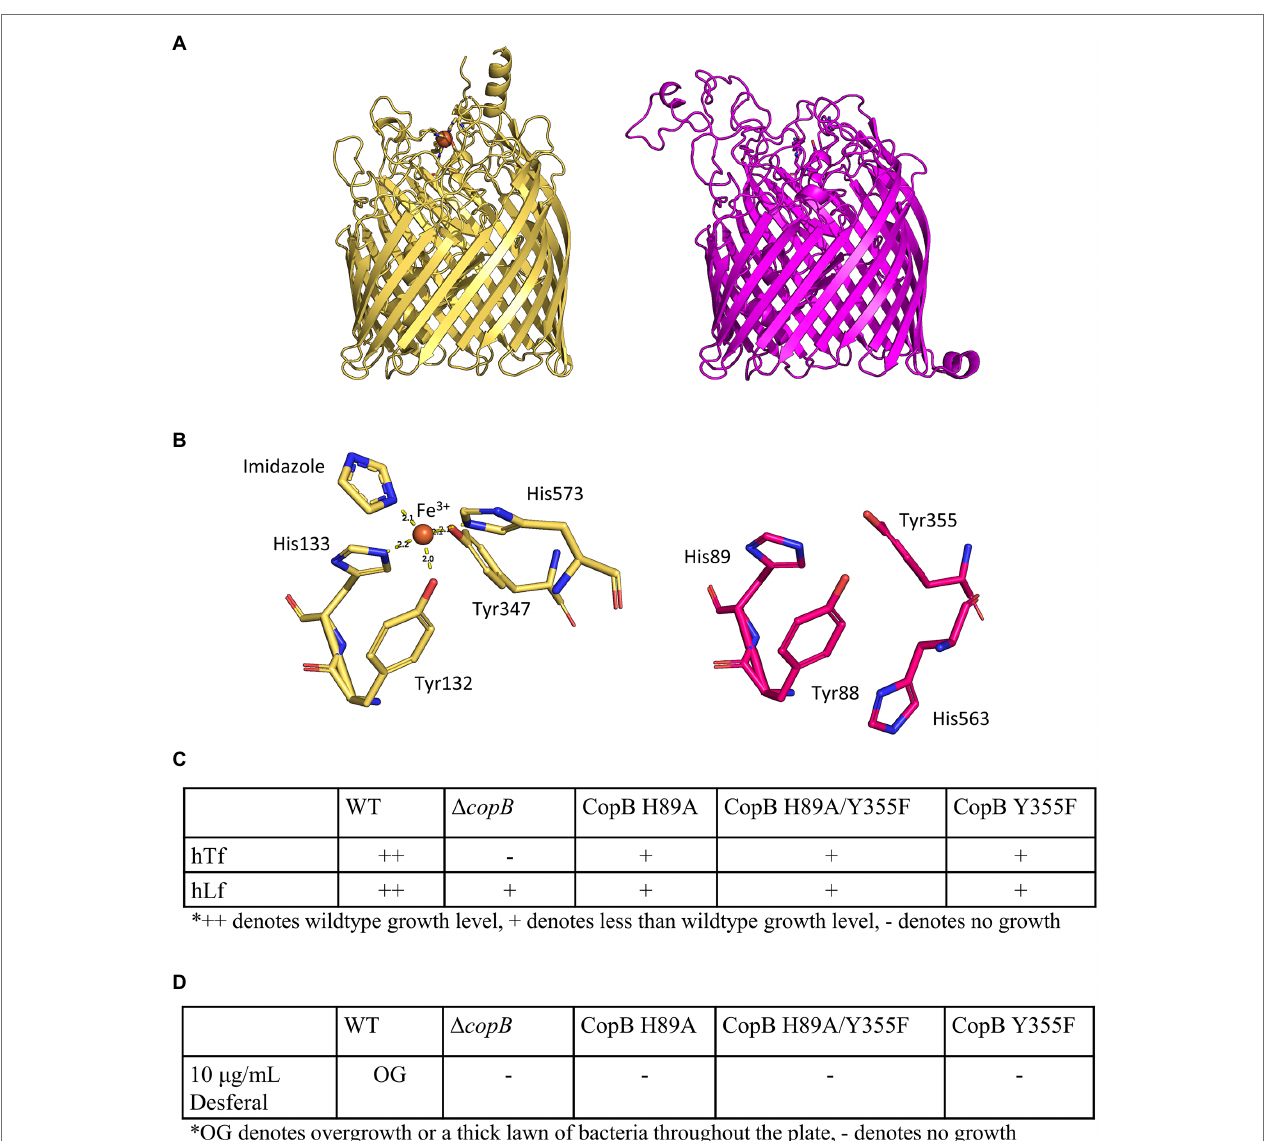
FIGURE 6 | Impact of iron binding mutants of CopB on growth. (A) Crystal structure of iron-holo Neisseria meningitidis FetA (PDB ID: 4AIQ) (tan) and homology model of M. catarrhalis CopB (magenta). (B) Neisseria meningitidis FetA iron-binding residues (tan) and putative iron-binding residues (magenta). (C) Growth phenotypes of CopB iron-binding residue mutants on BHI plus 50 μ g/ml Desferal with hTf or hLf as sole iron source. (D) Growth phenotypes of CopB iron-binding residue mutants on BHI plus 10 μ g/ml Desferal without any exogenous iron